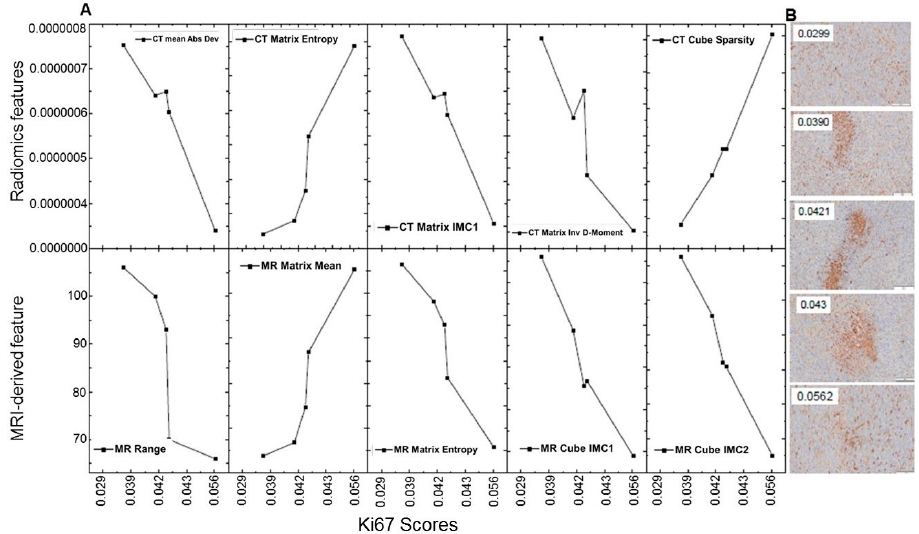
Figure 3. Dependence of five CT ( A top row) and five MRI ( A bottom row) radiomics features on post-treatment histochemistry proliferation marker Ki-67. The CT features ( A top row) are mean absolute deviation 3D, cube IMC1, matrix IMC1, matrix inverse difference moment, and cube sparsity. The MRI features (bottom row) are mean absolute deviation 3D, matrix mean, matrix entropy, cube IMC1, and cube IMC2. Also, ( B ) the column on the right contains the histology slides with Ki-67 values denoted in the top left corner of each slide. The Ki-67 increases from top to bottom, as can be observed from the increasing amount of red-brown stain on the slides.